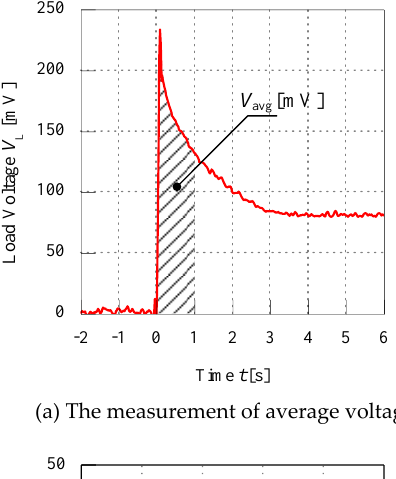
Figure 6. Data evaluation.